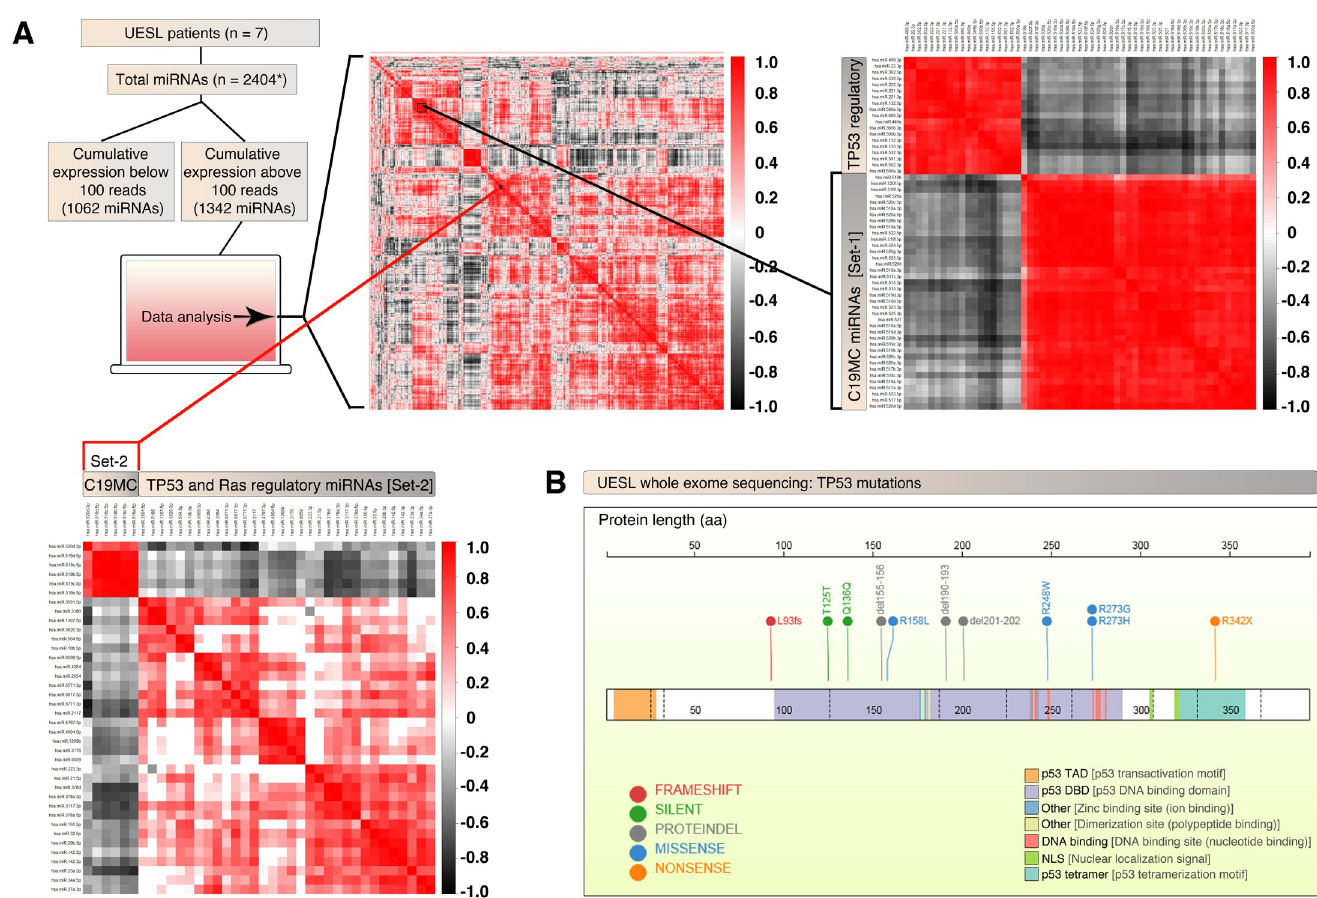
Fig 4. UESL display frequent TP53 mutations and exhibit negative correlation of C19MC miRNAs to TP53 and KRAS-regulatory miRNAs. A, Small RNA-seq of UESL samples were subjected to C19MC miRNA correlation analysis with miRNA transcriptome of 1342 miRNAs (that had a cumulative reads of 100 or more) that were selected from a total of 2404 miRNAs (counting 5p and 3p separately). C19MC miRNAs fall into two clusters (top left heatmap): a large cluster which is negatively correlated to many TP53 regulatory miRNAs (top right heatmap) and a smaller cluster which is negatively correlated to both TP53 and KRAS regulatory miRNAs (bottom left heatmap). B, UESL harbor an assortment of TP53 mutations as evaluated by whole exome sequencing. Notably, almost all mutations are truncation or known oncogenic missense